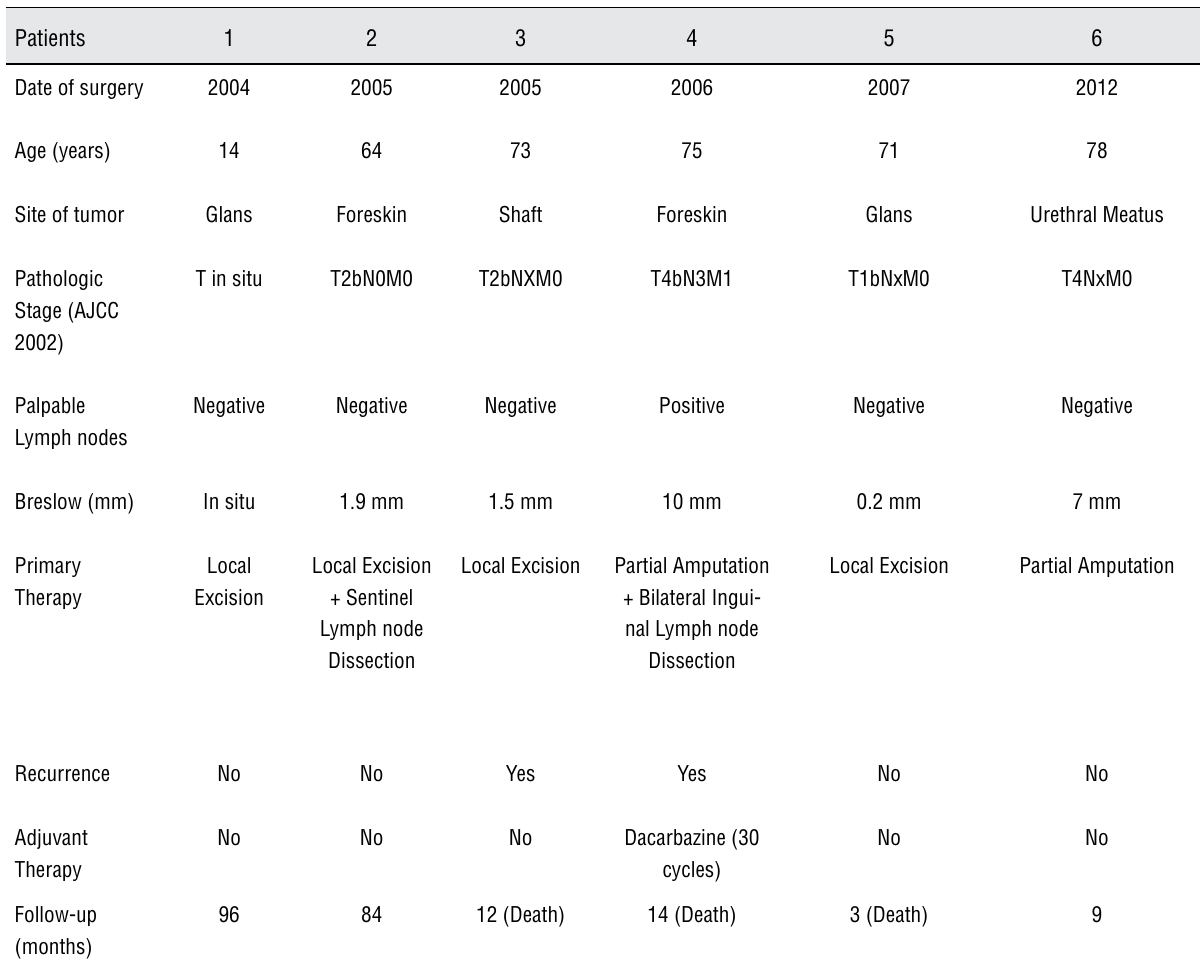
Table 1 - Clinical and pathologic characteristics of the tumors studied.